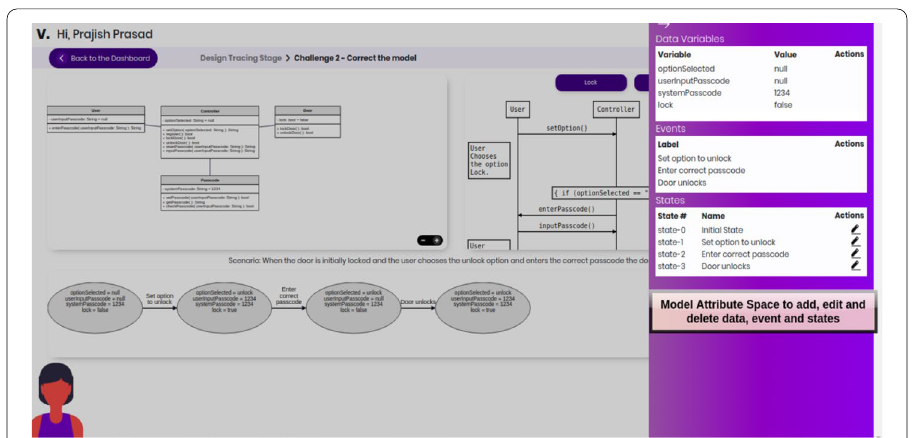
Fig. 11 The model attribute space in the Design Tracing Stage